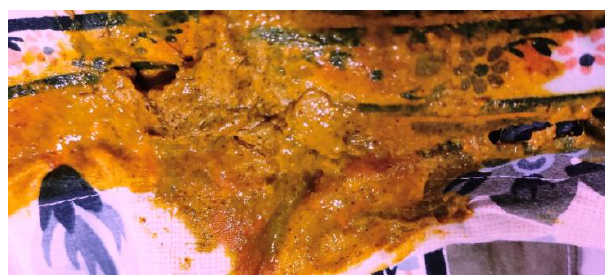
Figure 2: Minute black fibers observed in the infant stool,